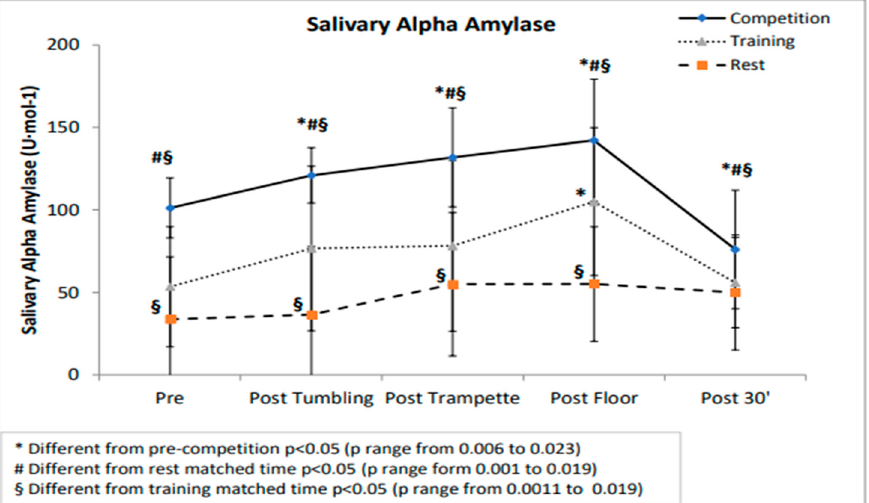
Figure 1. Salivary alpha-amylase values during the competition, training ad rest day.